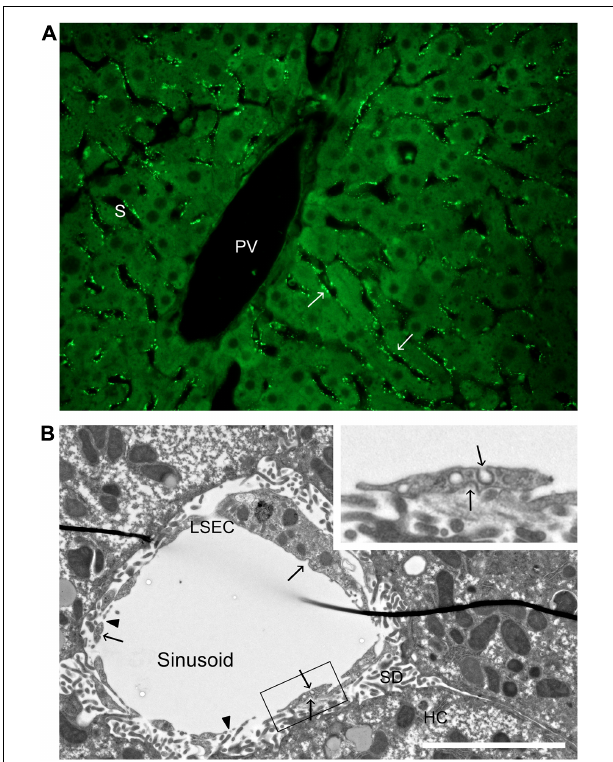
FIGURE 2 | Distribution of a soluble scavenger receptor ligand in the hepatic lobule, and ultrastructure of a liver sinusoid. (A) Uptake of FITC-FSA (formaldehyde-treated serum albumin) in mouse liver, 10 min after intravenous administration (dose 2 µ g/g bodyweight). Arrows points to FITC-FSA (bright green) located along the sinusoids (S), in a pattern typical of uptake in LSECs. PV, portal vein. (B) Transmission electron micrograph of a rat liver sinusoid. The inserted image is a magnification of part of the LSEC in the main image. Arrows point to coated pits and arrow heads to fenestrae. LSEC, liver sinusoidal endothelial cell; SD, space of Disse; HC, hepatocyte. Scale bar 5 µ